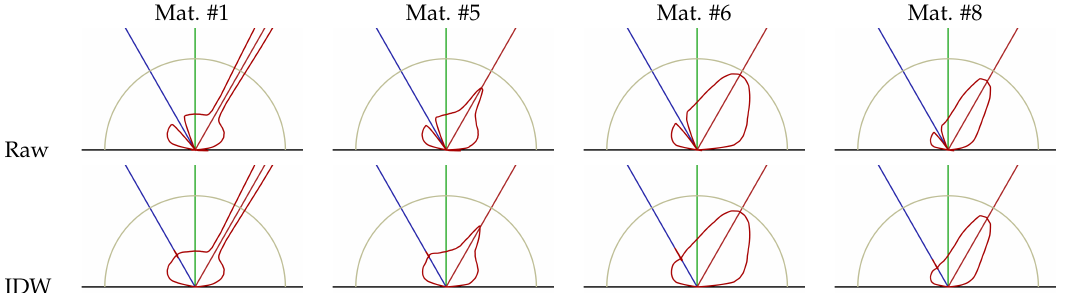
Figure 4. BRDF raw data and IDW interpolation results for materials #1, #5, #6 and #8 acquired for an incident light angle θ i = 30 ◦ . The blue ray indicates the incident light direction, the red ray the ideally reflected incident light direction and the red curve the BRDF value related to the corresponding ray from the center to a point of this curve.